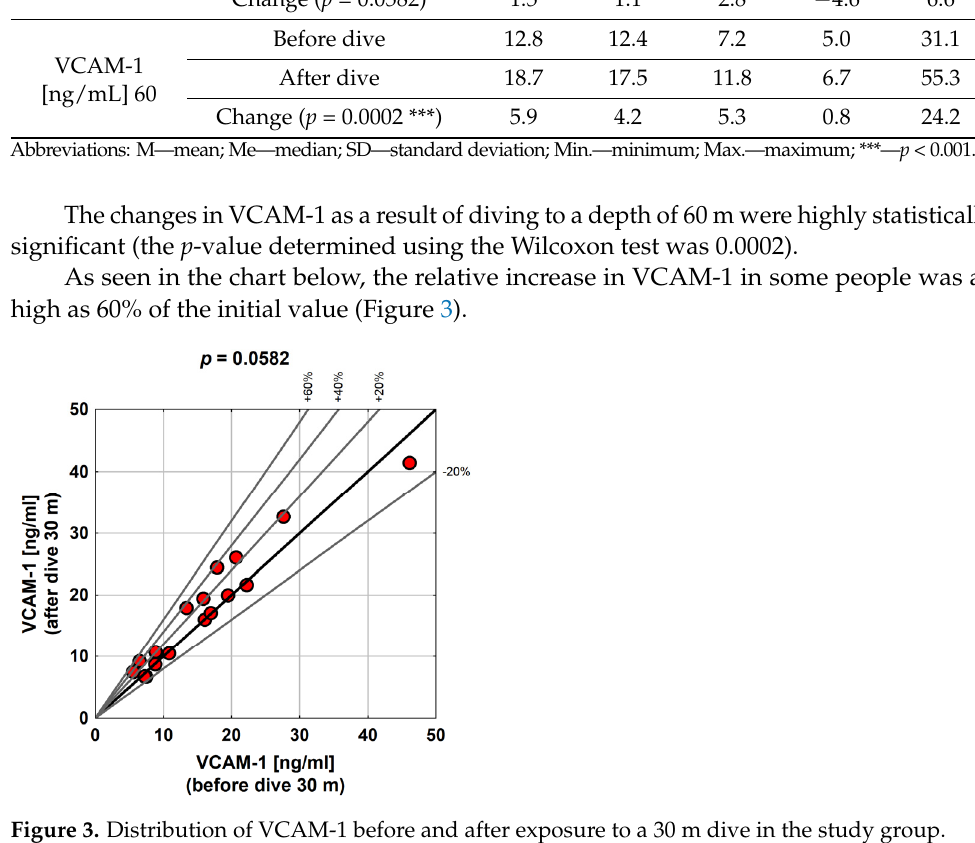
Figure 3. Distribution of VCAM-1 before and after exposure to a 30 m dive in the study group. As presented in the graph below (Figure 4), the relative increase in VCAM-1 over the baseline was as high as 80% (i.e., in some subjects, VCAM-1 was almost twice as high after diving).